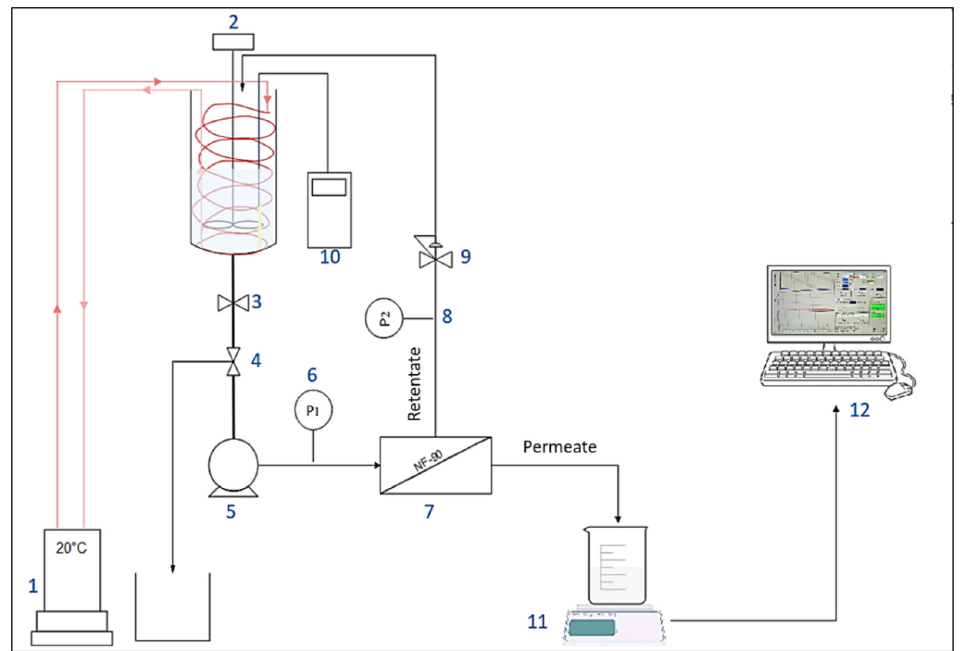
Figure 1. Experimental setup of nanofiltration bench-scale pilot. ( 1 ) Cryothermostat. ( 2 ) Mechanical stirrer. ( 3 ) Tank isolation valve. ( 4 ) Valve for sampling. ( 5 ) Pump. ( 6 ) And. ( 8 ) Pressure sen- sors. ( 7 ) Filtration unit. ( 9 ) Pressure control valve. ( 10 ) Conductivity meter. ( 11 ) Precision scale. ( 12 ) Data